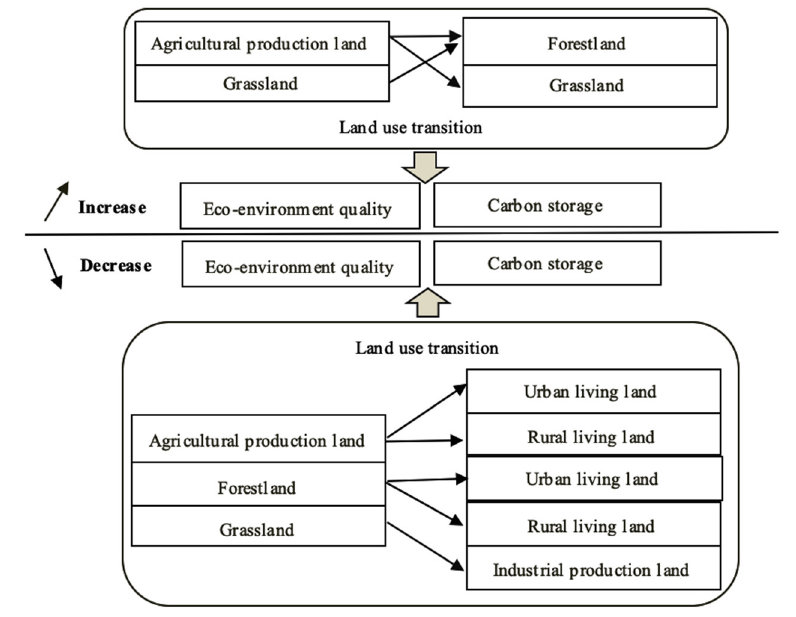
Figure 9. The driving mechanism of land use transition on eco-environment effects in the BTH region.